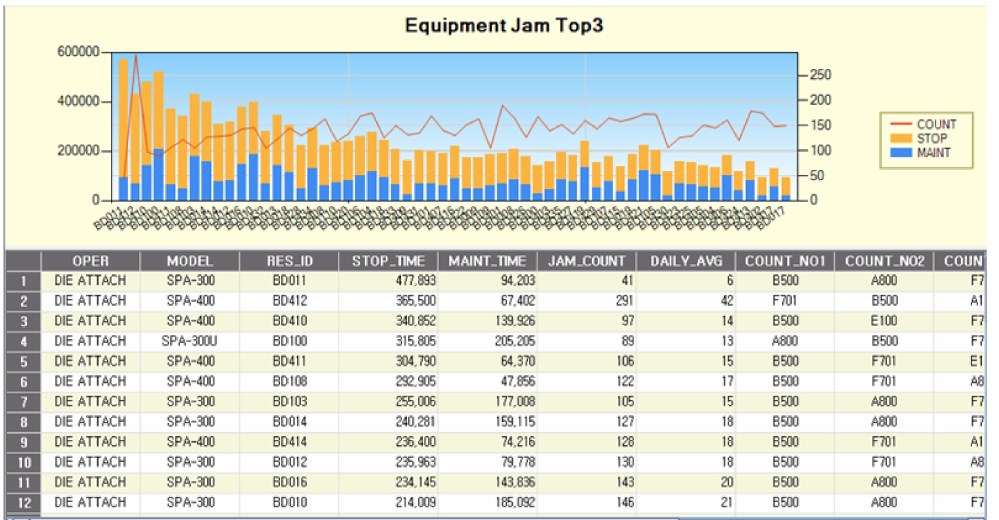
Figure 5. The number of losses, the number of times the equipment stoppage (STOP), and the number of maintenance (MAINT) by die attach process equipment.